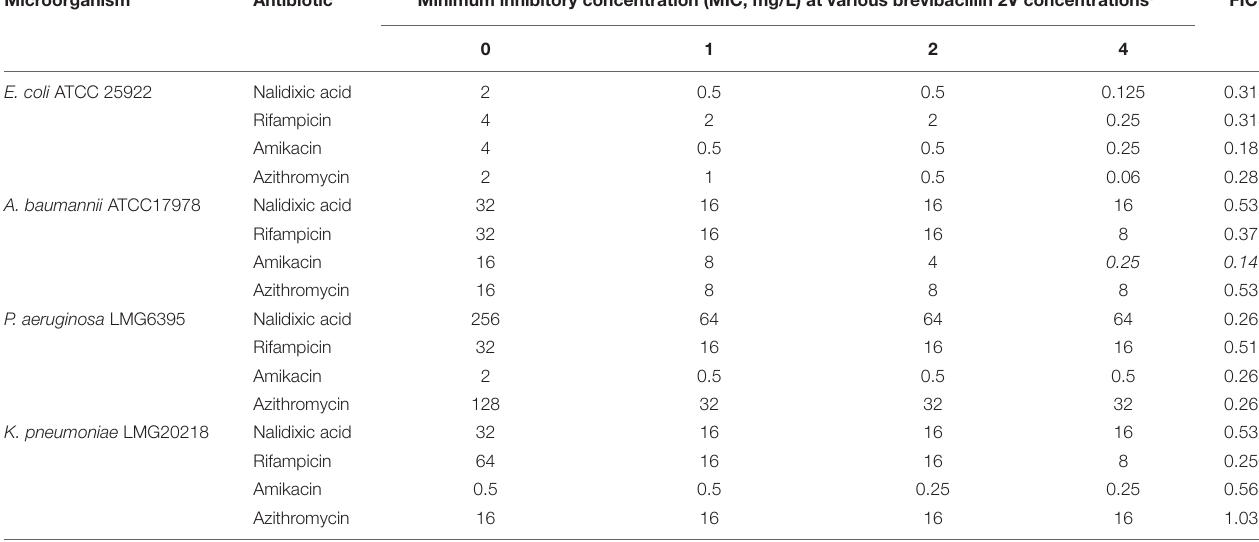
TABLE 2 | Synergistic effect between brevibacillin 2V and antibiotics.